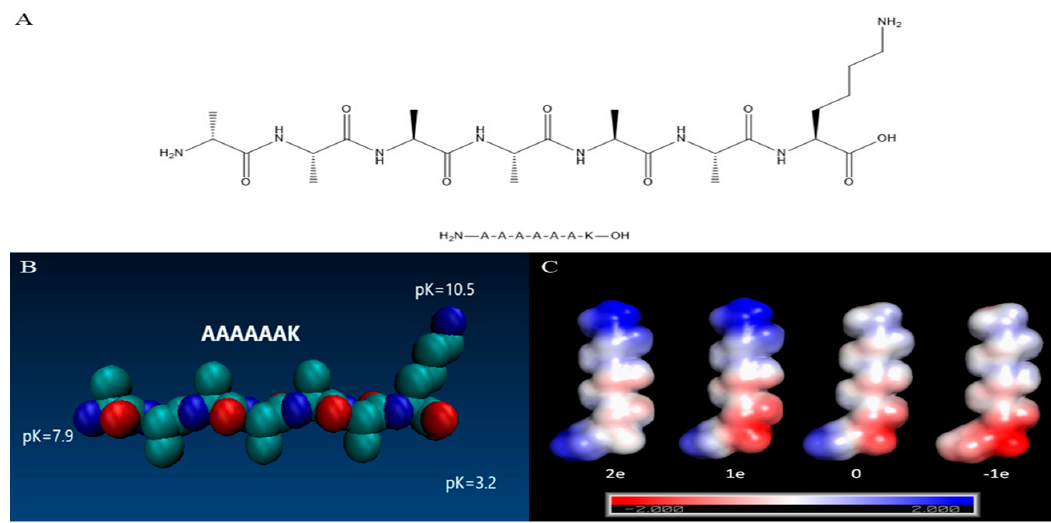
Figure 1. ( A ) Structure of A 6 K. ( B ) Space filling model of A 6 K peptides. pKa values for charged groups were calculated using APBS (adaptive Poisson–Boltzmann solver). ( C ) Electrostatic potential (kBTe (eV)) mapped onto the solvent accessible surface of the A 6 K peptide at pH = 2, 7, 8, and 11 (left-to-right, correspondingly). The net charge of A 6 K is written under the model.